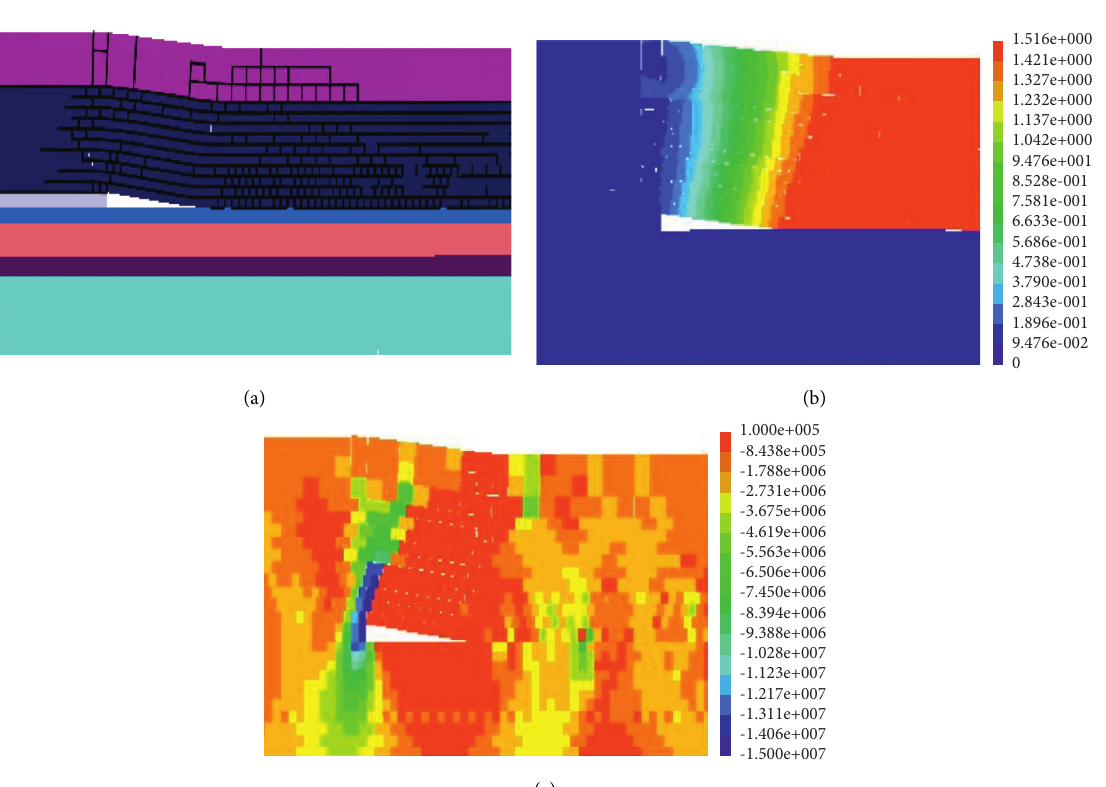
Figure 8: The situation surrounding the mining of the upper coal seam. (a) Collapse of rock mass. (b) Nephogram of stope displacement. (c) Vertical stress cloud map of